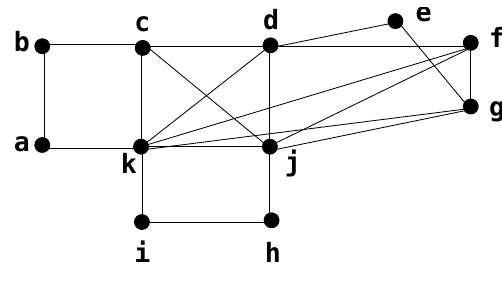
Figure 1. Graph G , our running